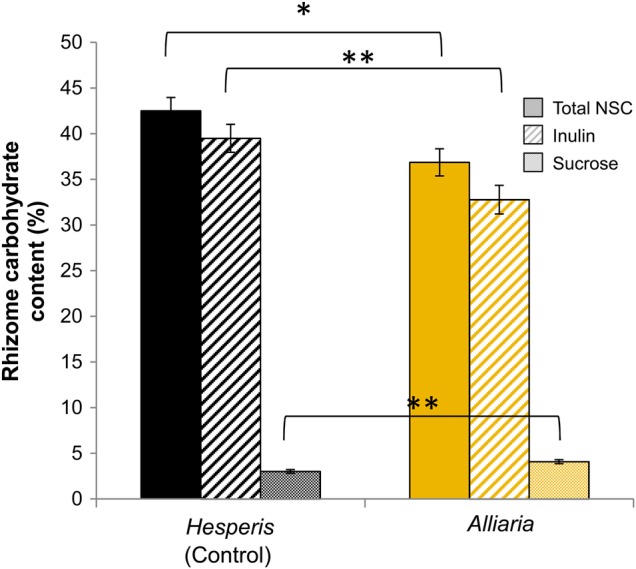
Maianthemum racemosum rhizome carbohydrate content (%) from Alliaria (yellow) and Hesperis (control; black) treatments in the greenhouse experiment. Total NSC content is shown in solid-coloured bars. Total NSC is a composite measure of stored sugars (inulin; bars with diagonal shading) and mobile sugars (sucrose; stippled bars). Values are least squares means from ANCOVAs ±1 standard error. *P < 0.05; **P < 0.005.